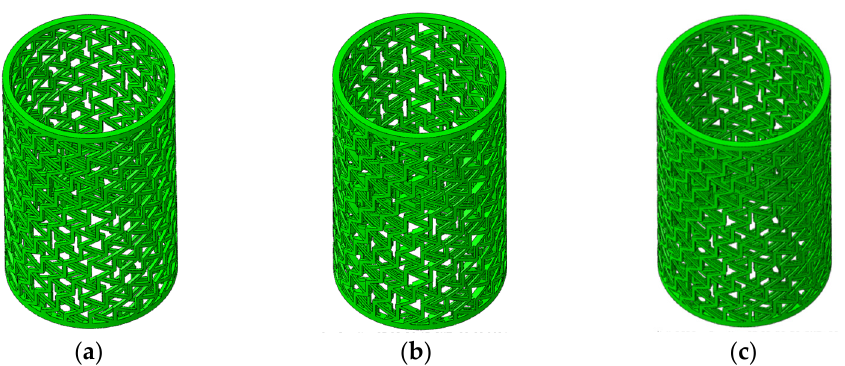
Figure 21. The composite RHCSs: ( a ) double-layer RHCS; ( b ) three-layer RHCS; ( c ) four-layer RHCS.